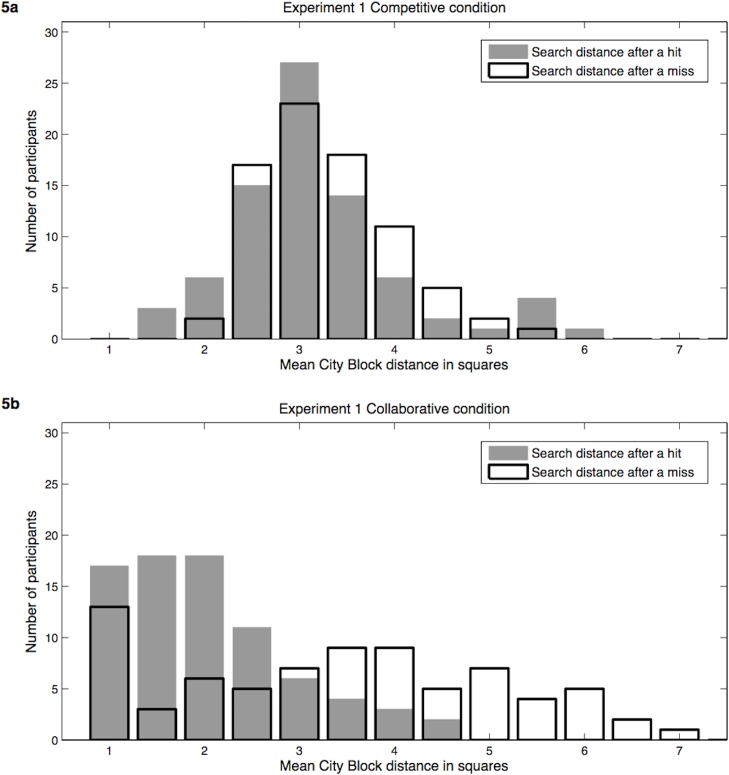
Distribution of each participant’s mean search distance after successfully finding a token (a hit) or clicking on an empty location (a miss).(a) Experiment 1 competitive condition, (b) Experiment 1 collaborative condition.